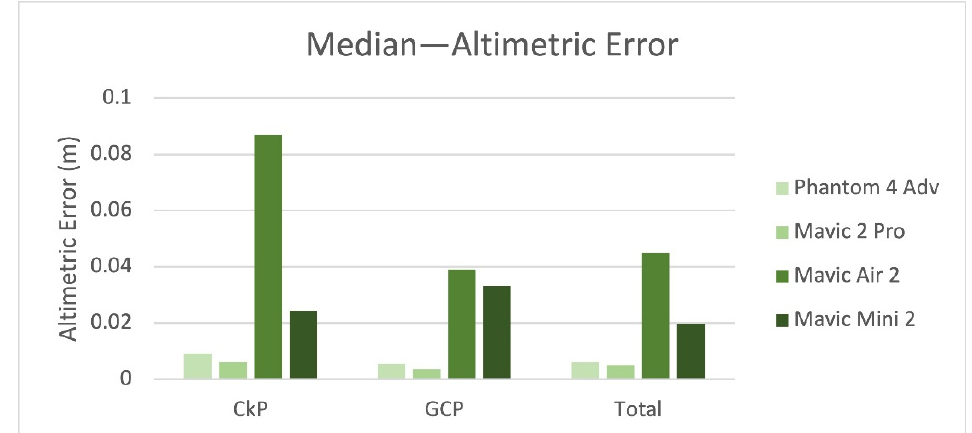
Figure 15. Chart of median calculated for the altimetric error.